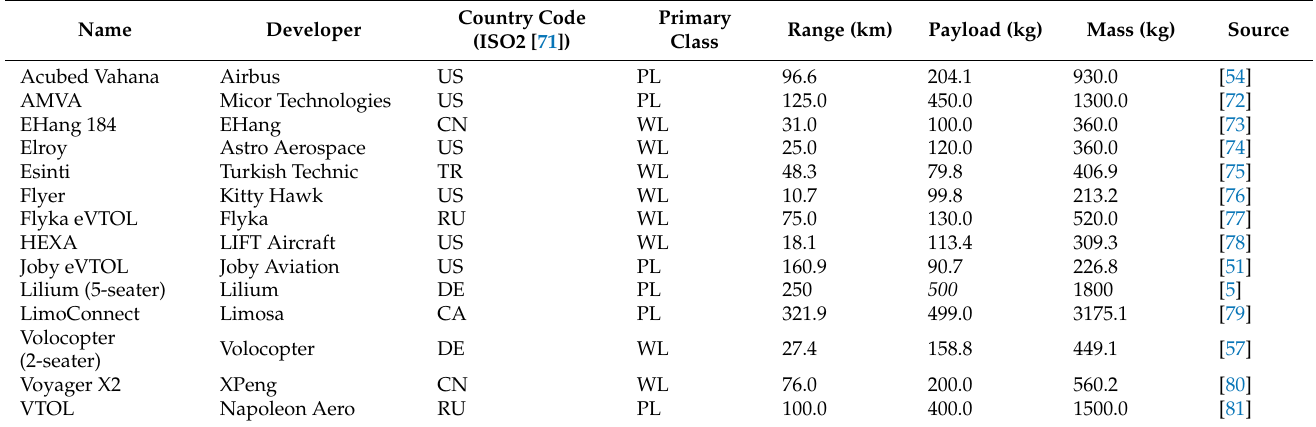
Table A1. Select eVTOL aircraft performance